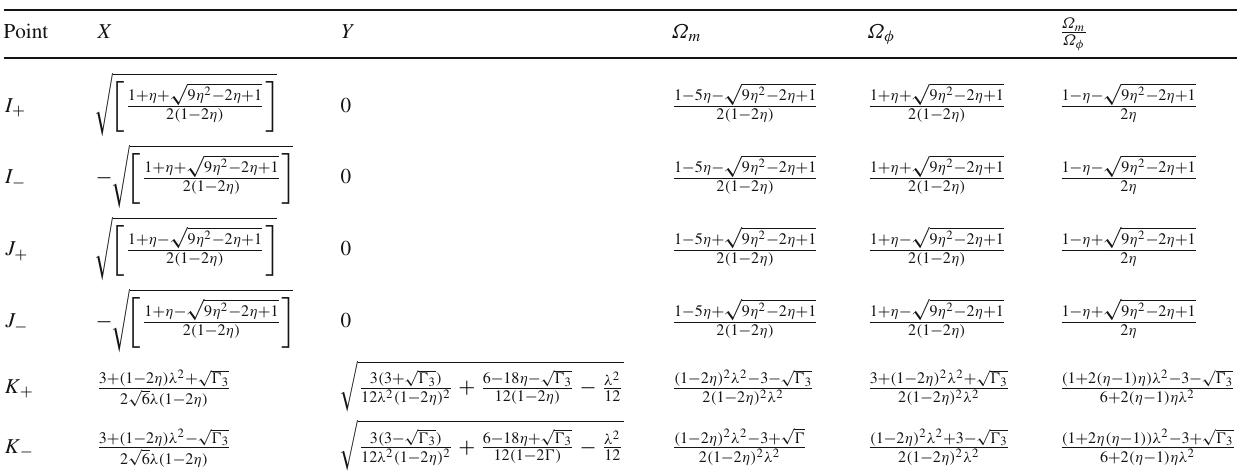
Table 6 Critical points of the dynamical system for α = − β ≡ η Point X Y Ω m Ω φ Ω m Ω